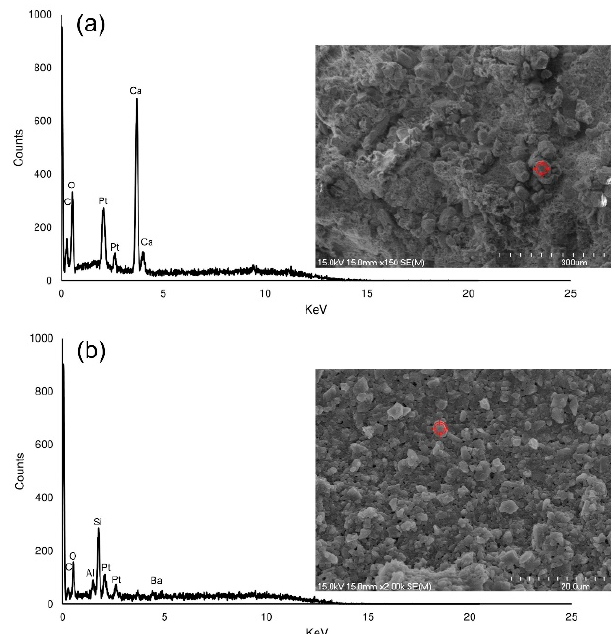
Figure 6. Energy-dispersive X-ray (EDS) spectra of the dental composite: ( a ) supplemented with urease enzyme (self-healing composite) and ( b ) without urease enzyme (control).